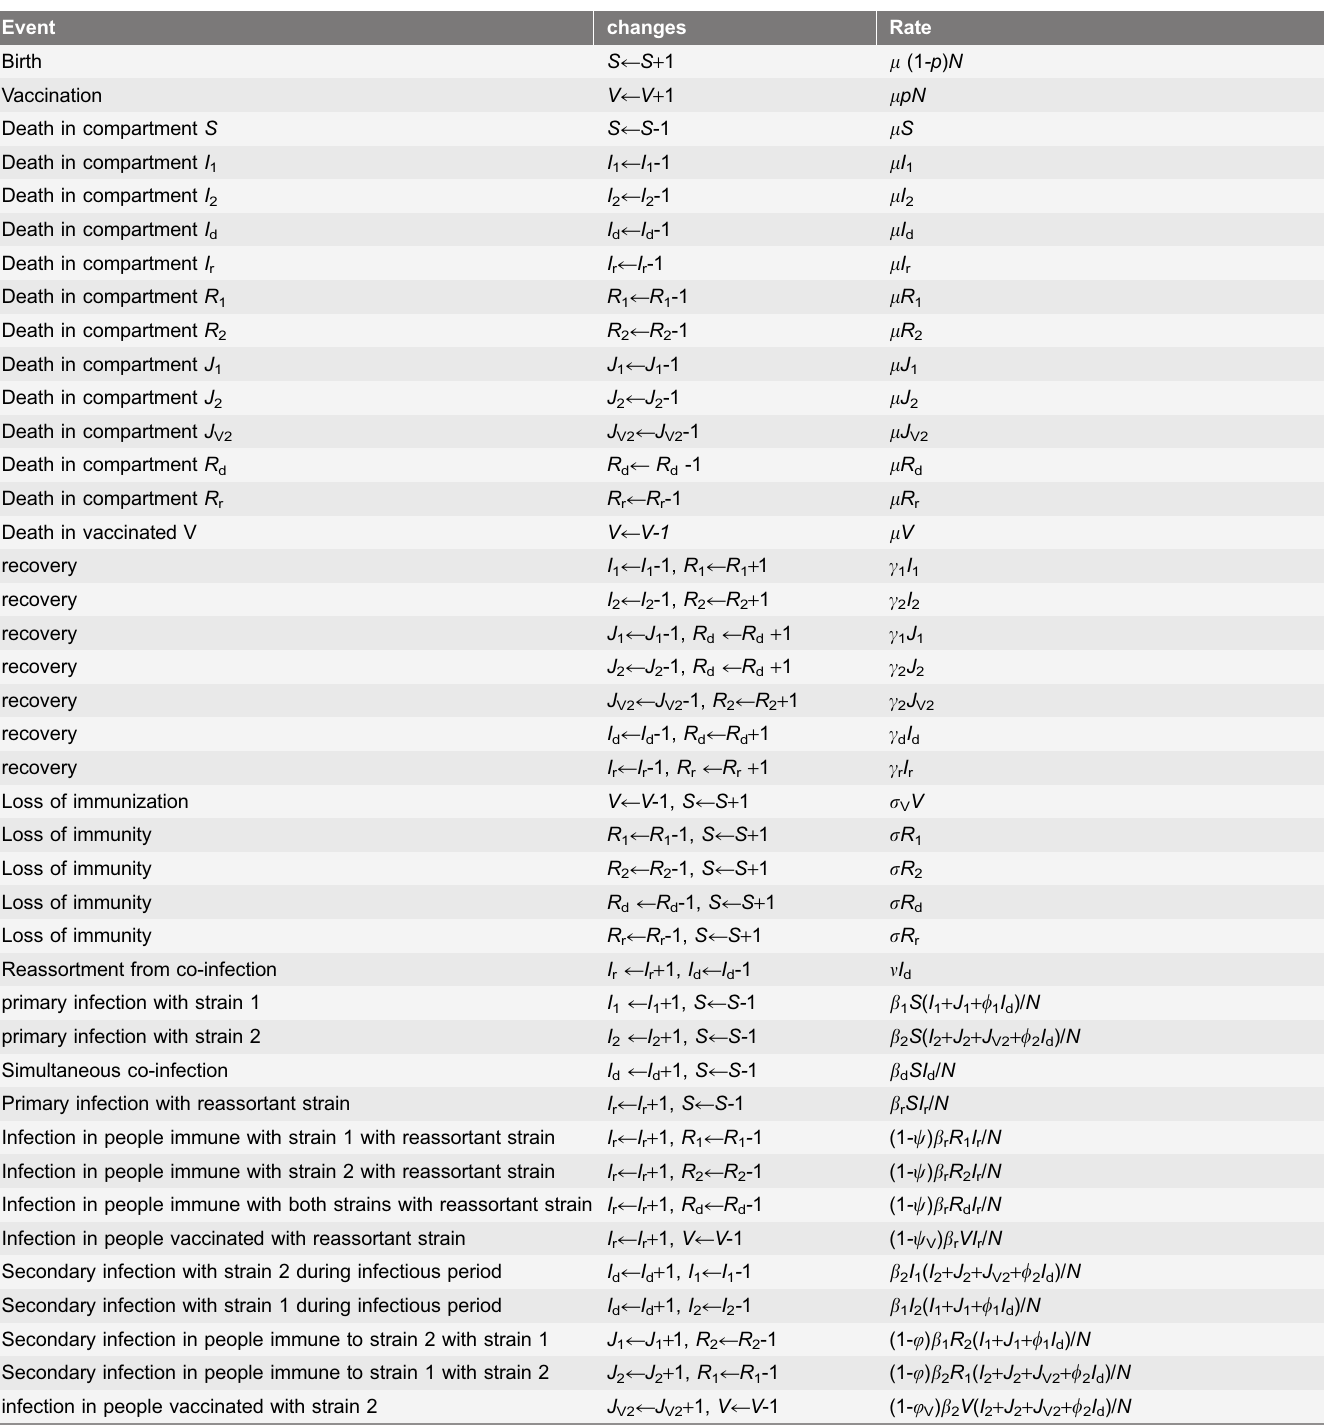
Table 2. List of 41 events of the whole model